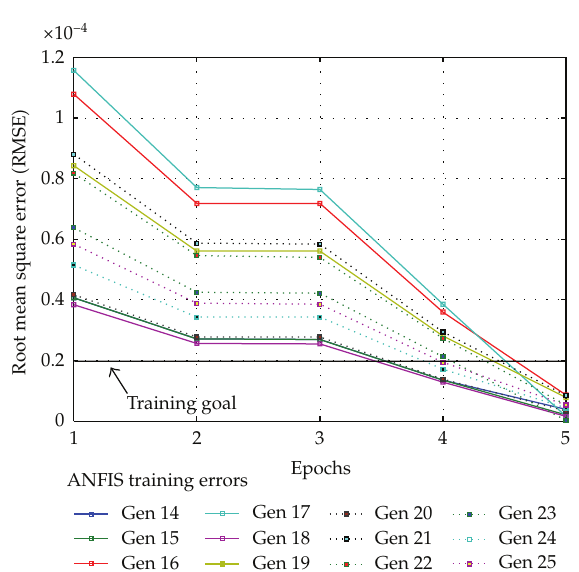
Figure 5: Training curves for individual ANFIS blocks.